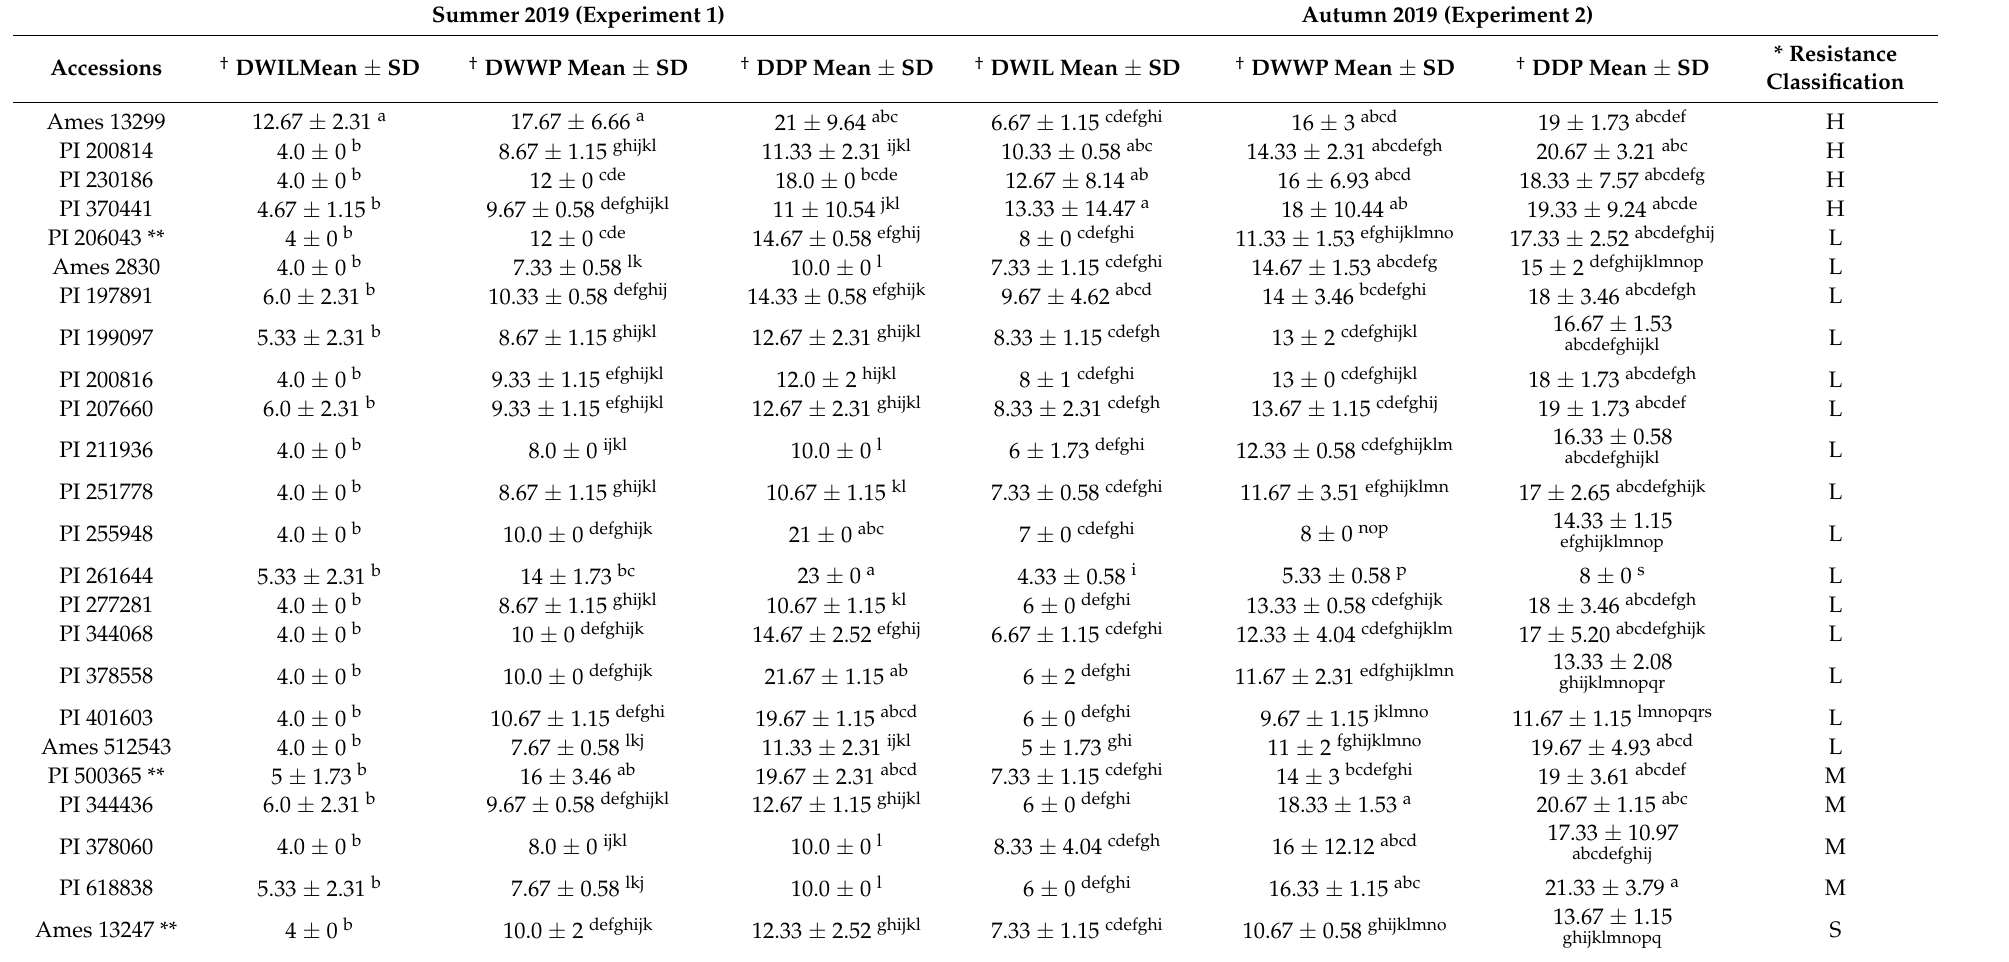
Table 1. Disease severity of melon and cucumber lines inoculated with E. tracheiphila Hca1-5N in Summer 2019 and Autumn 2019 screening